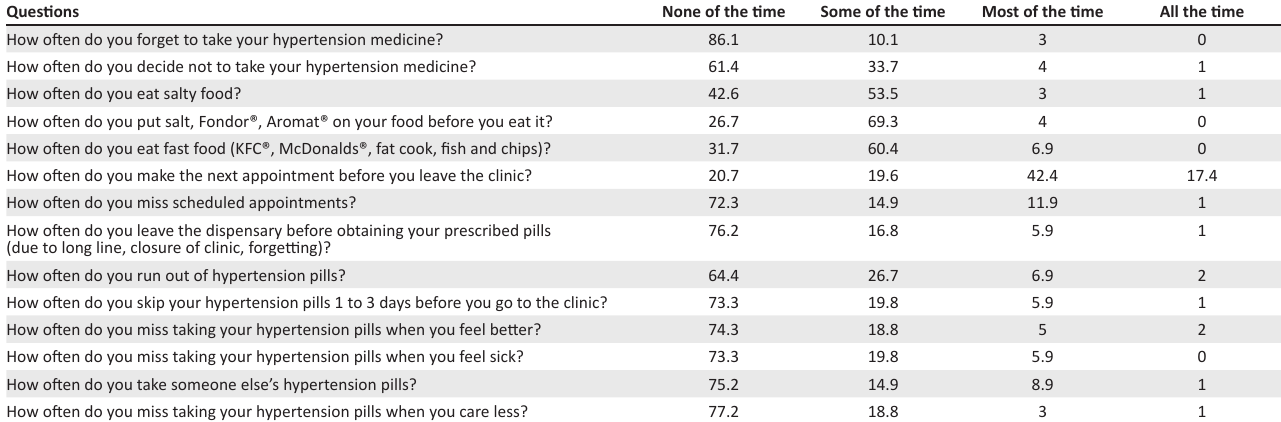
TABLE 2 : Hill-Bone Compliance to High Blood Pressure Therapy Scale in percentage ( n = 101). Questions